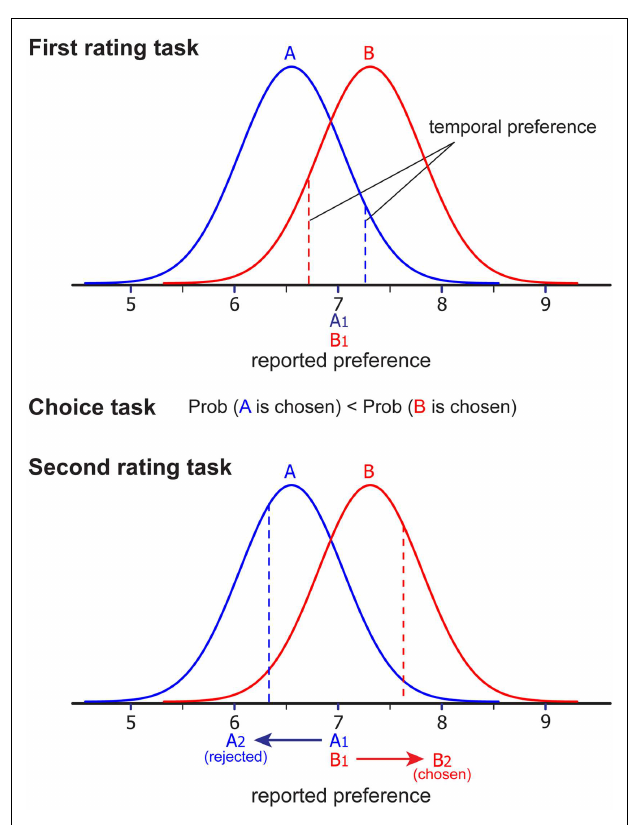
FIGURE 2 | Schematic illustration of how the free-choice paradigm produces artificial spreading of alternatives in the simulation study. Each normal curve represents the distribution of participant’s preference (true preference + random noise) for item A (blue) and B (red). In our simulation study, participants’ temporal preference for each item was randomly drawn from each distribution, and these numbers are rounded to the nearest integer that represents participants’ reported preference for each item. In this example, reported preferences for both items are 7 (A1 = B1 = 7).When a participant is asked to make a choice between A and B in the choice task, B is more likely to be chosen because true preference for B is higher than that for A.Then, when participants’ temporal preference for each item was randomly drawn for the second time from the same distribution (preference rating task 2), temporal preference for A2 (rejected item) is likely to decrease, while temporal preference for B2 (chosen item) is likely to increase purely by chance. Accordingly, reported preference for A is also likely to increase, while reported preference for B is likely to decrease (A2 = 6, B2 = 8 in this example). Note that distributions for each item A and B stay the same across two preference rating tasks, indicating that there is no change in participants’ true